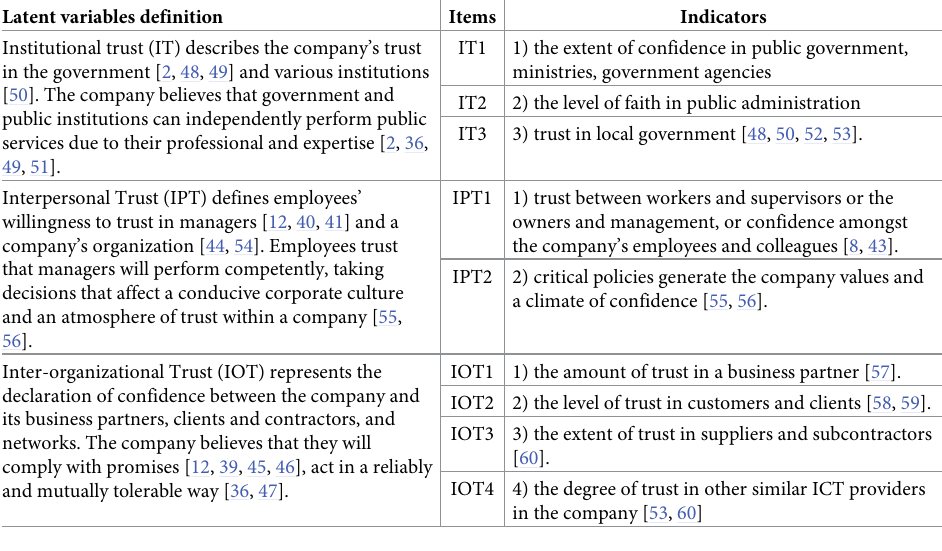
Table 1. Variables and operational